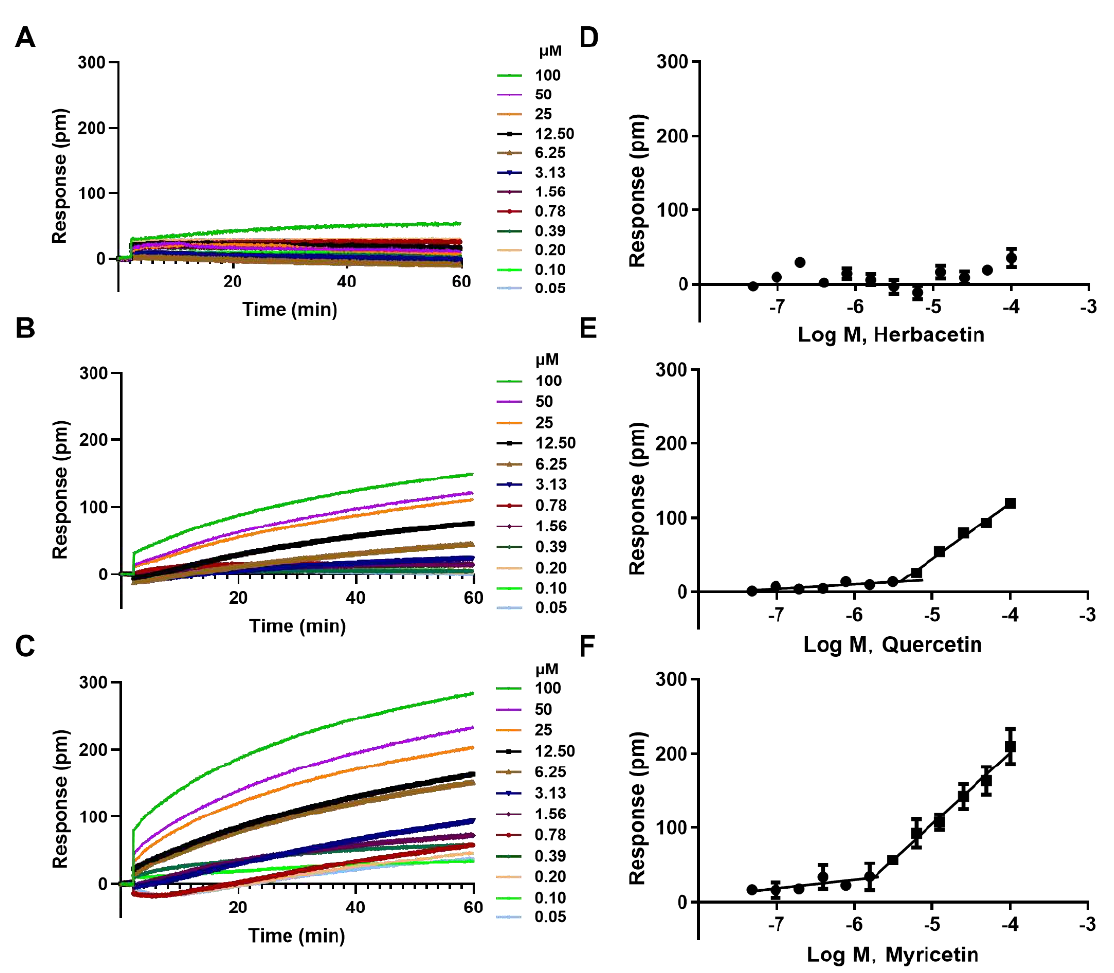
Figure 3. Cell–free aggregation analyses of three typical flavonoids: DMR responses of herbacetin ( A ); quercetin ( B ); and myricetin ( C ); and corresponding concentration–response curves ( D – F ).